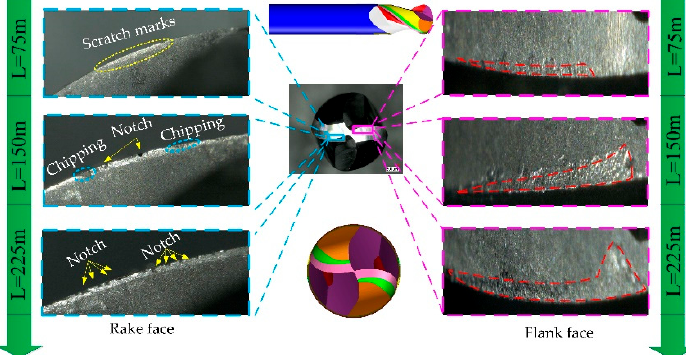
Figure 13. Tool wear morphology of ball-end milling cutter with different milling length.